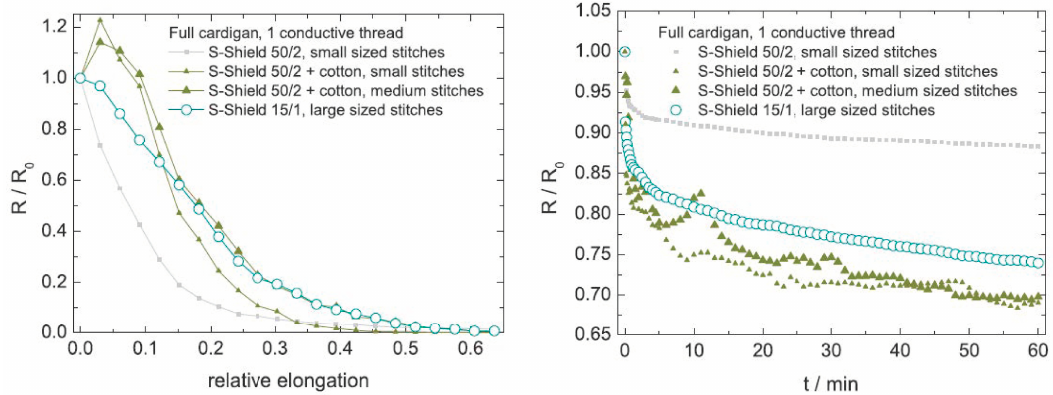
Figure 12. E ff ect of yarn materials [62]. Figure 12. Effect of yarn materials [62]. Figure 12. Effect of yarn materials [62].